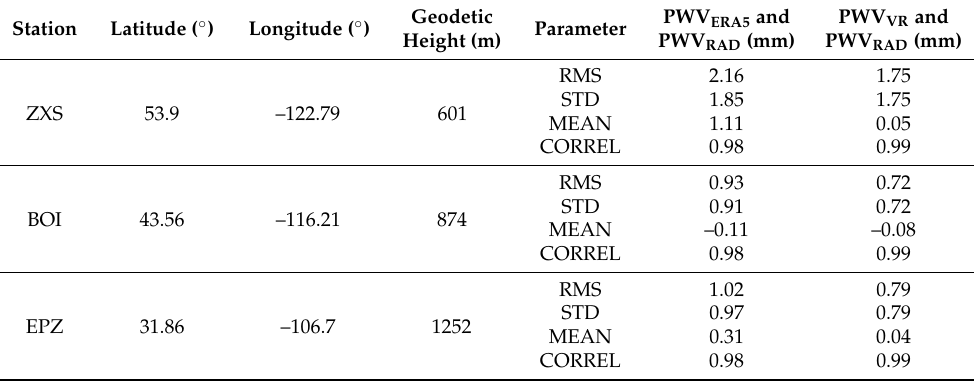
Table 4. PWV of virtual radiosonde station network (PWV VR ) accuracy